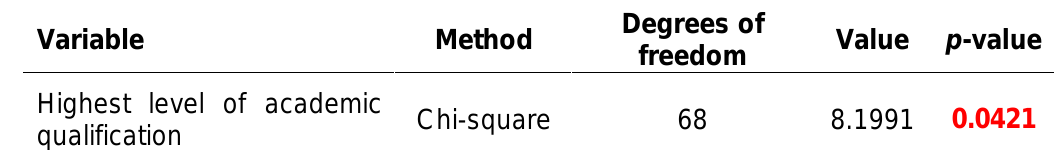
Table 4: Significant Differences Relating to Education